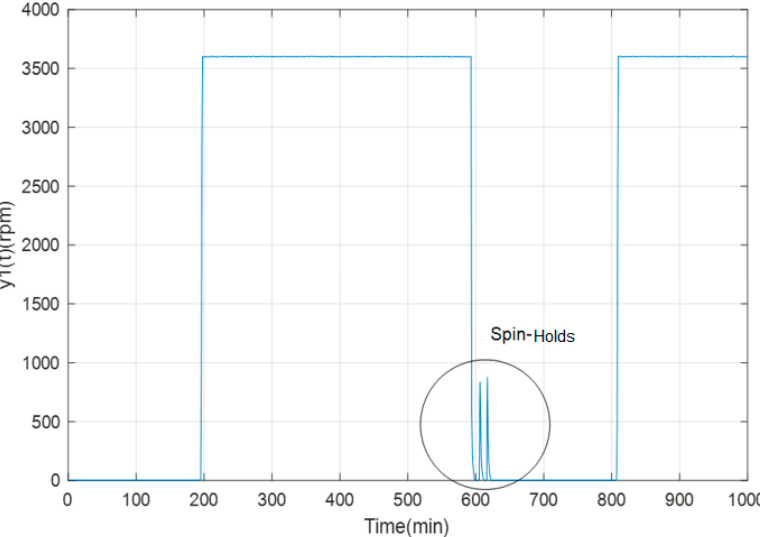
Figure 8. Spin-Holds of the angular velocity of the TGL.